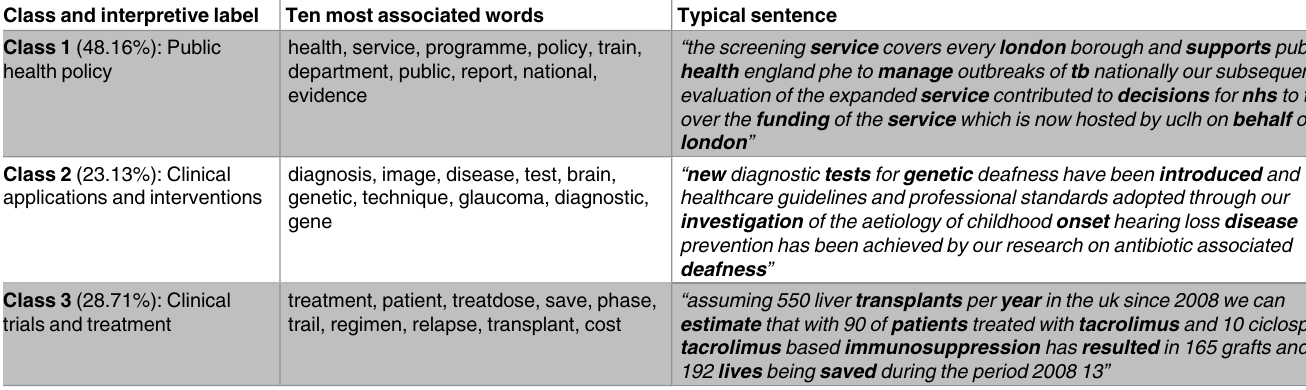
Table 4. Panel A–Life Sciences